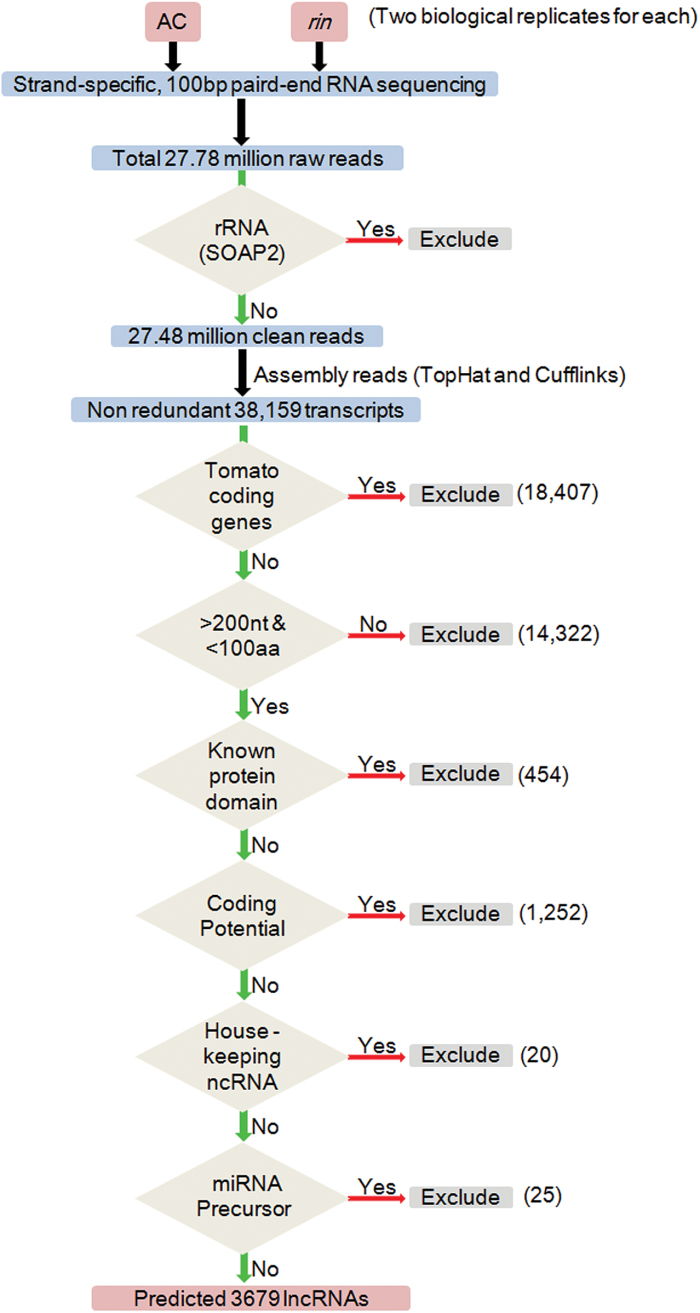
Detailed schematic diagram of the informatics pipeline for identification of tomato lncRNAs. Paired-end strand-specific RNA-Seq was performed for AC and rin fruits at the BR stage. Clean reads were mapped and assembled according to the known tomato genome using TopHat and Cufflinks. Transcripts were filtered with the six criteria for identification of putative lncRNAs. (i) Not tomato coding genes; (2) length >200 nucleotides and ORF <100 amino acids; (iii) not encoding known protein domains; (iv) little coding potential; (v) not housekeeping ncRNAs; and (vi) not miRNA precursors. At each step, a green arrow indicates those transcripts which were passed by the filter; a red arrow, those that were excluded. The number of transcripts that di not pass the filter is shown.